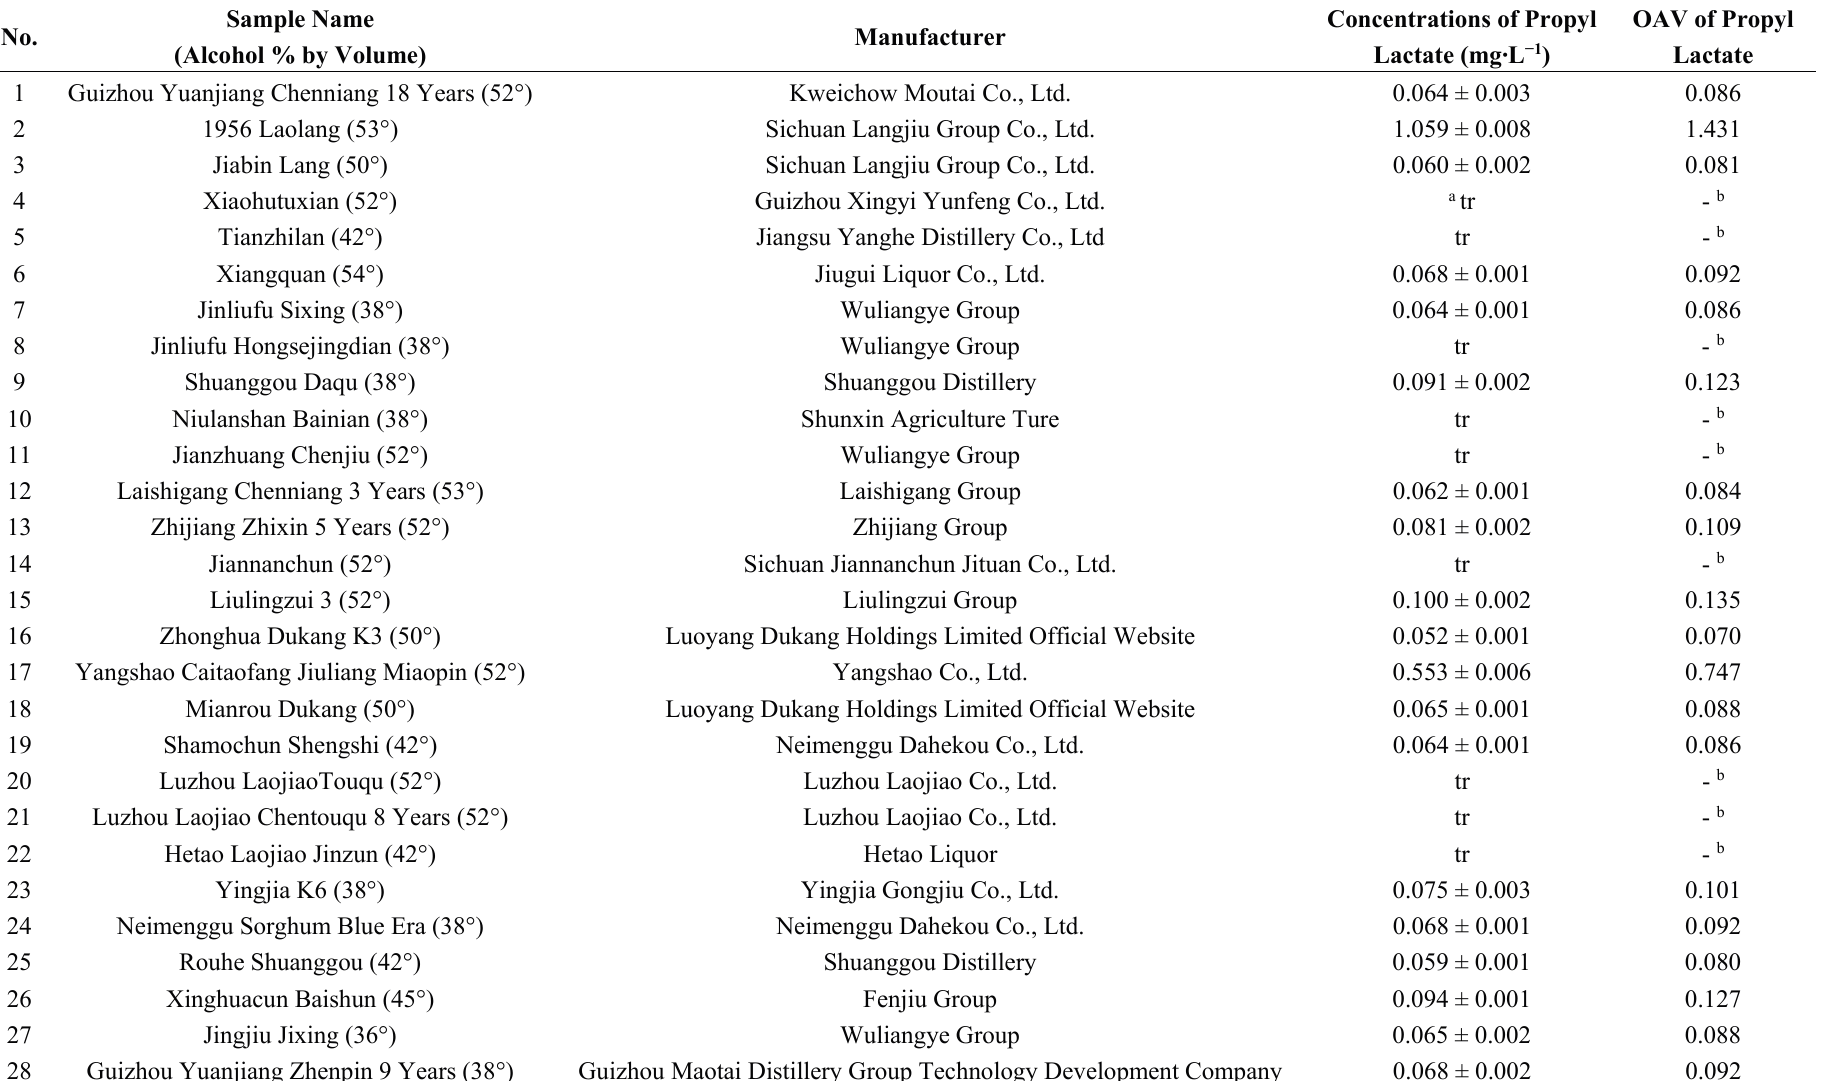
Table 1. The concentrations of propyl lactate in 82 Chinese Baijiu samples (Detection threshold 0.740 mg·L − 1